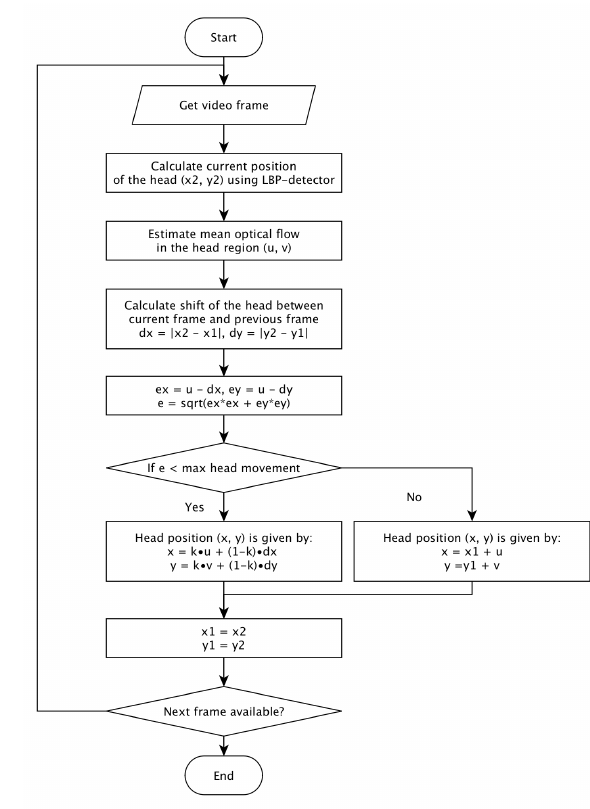
Figure 4. LBP-optical flow face tracker